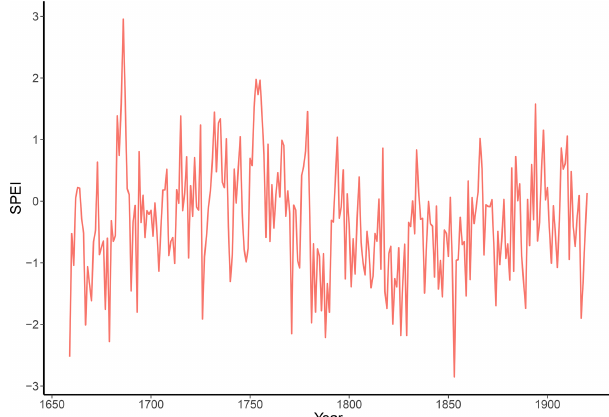
Figure 6. Reconstruction of southern Scandinavian SPEI, 1659– 1920. Source: Seftigen et al.